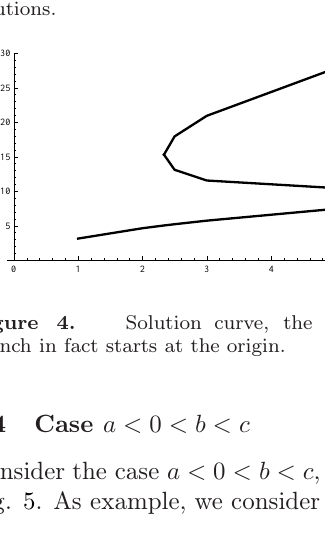
Figure 3. Function U and the respective solutions in the case of a = 1 , b = 2 , c = 7 : a) function U, λ = 1 , b) function U, λ = 2 . 33545 , c) λ = 1 one solution, d) λ = 2 . 33545 two solutions.